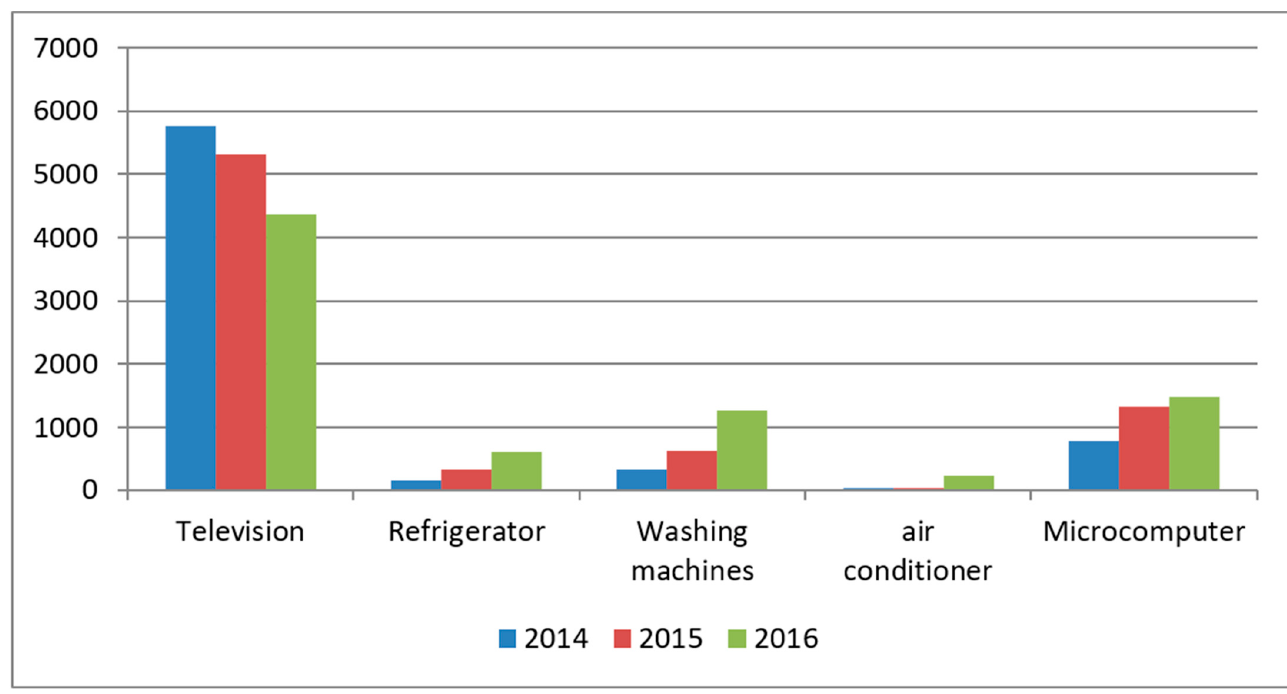
Figure 7. Actual quantity of major WEEEs dismantled in qualified processing enterprises in China from 2014 to 2016.